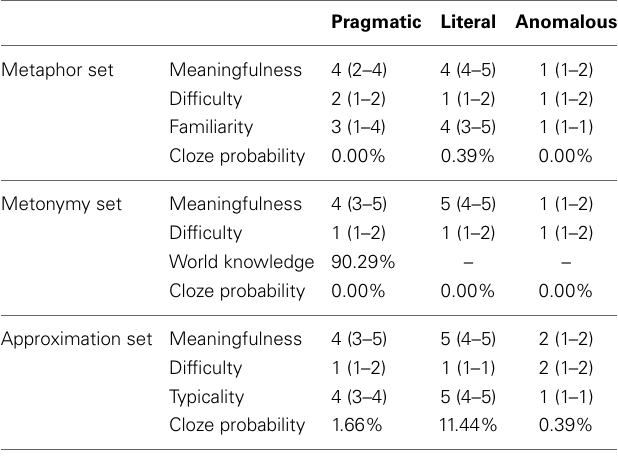
Table 2 | Descriptive statistics of rating scores for the Metaphor set, the Metonymy set, and the Approximation